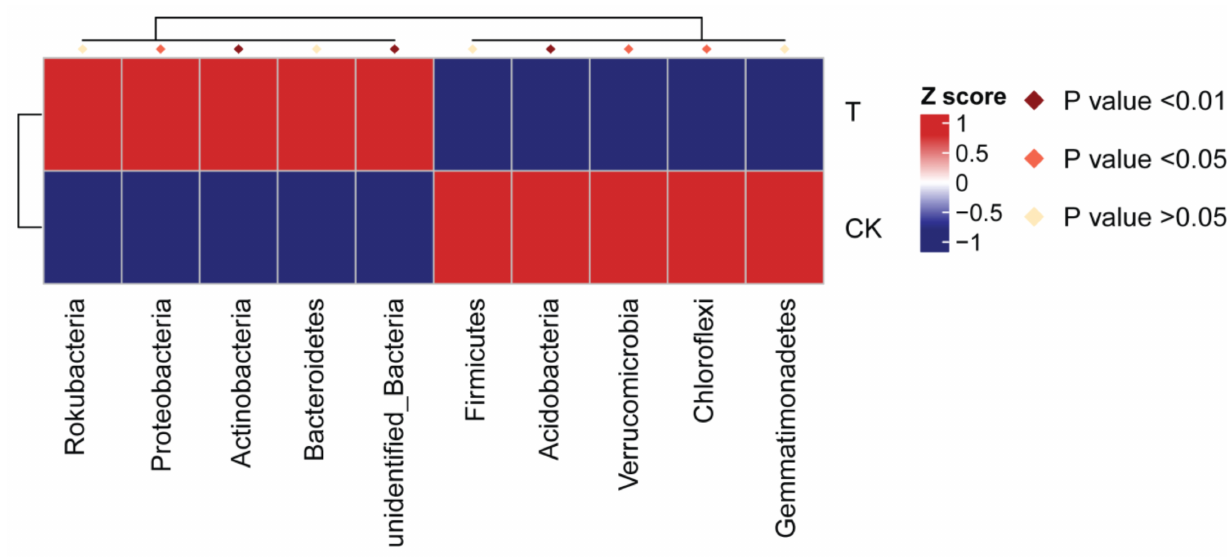
Figure 4. Relative abundance of bacterial phyla found to be significantly different between the bioorganic fertilizer and no-fertilizer treatments. The bacterial phyla composition was considered significantly different between treatments when the p -value was